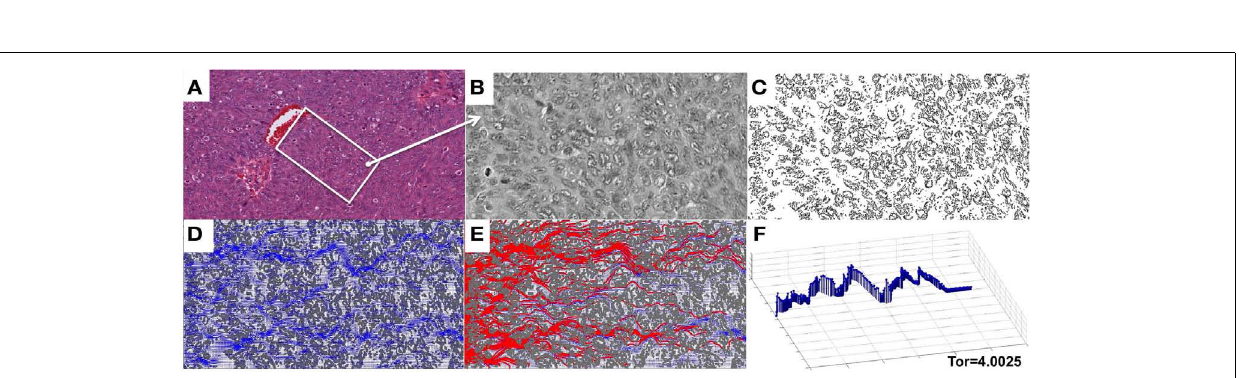
FIGURE 8 | Penetration of drug particles through a digitized ovarian tumor tissue. (A) An original H&E-stained histological image of ovarian tumor tissue with a centrally located vein. (B) A small patch of tissue selected from (A) and used for digitization. (C) A digitized version of the histological image